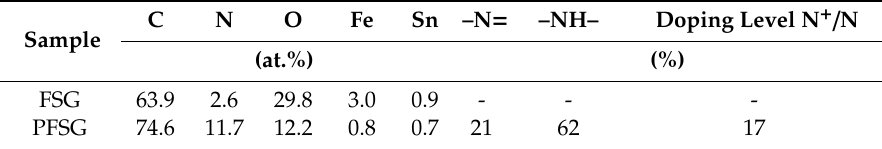
Figure 3. Deconvolutions of ( a ) C1s, ( b ) N1s, ( c ) Fe2p and ( d ) Sn3d for the ternary composite. Table 2. Elemental surface compositions of FSG and